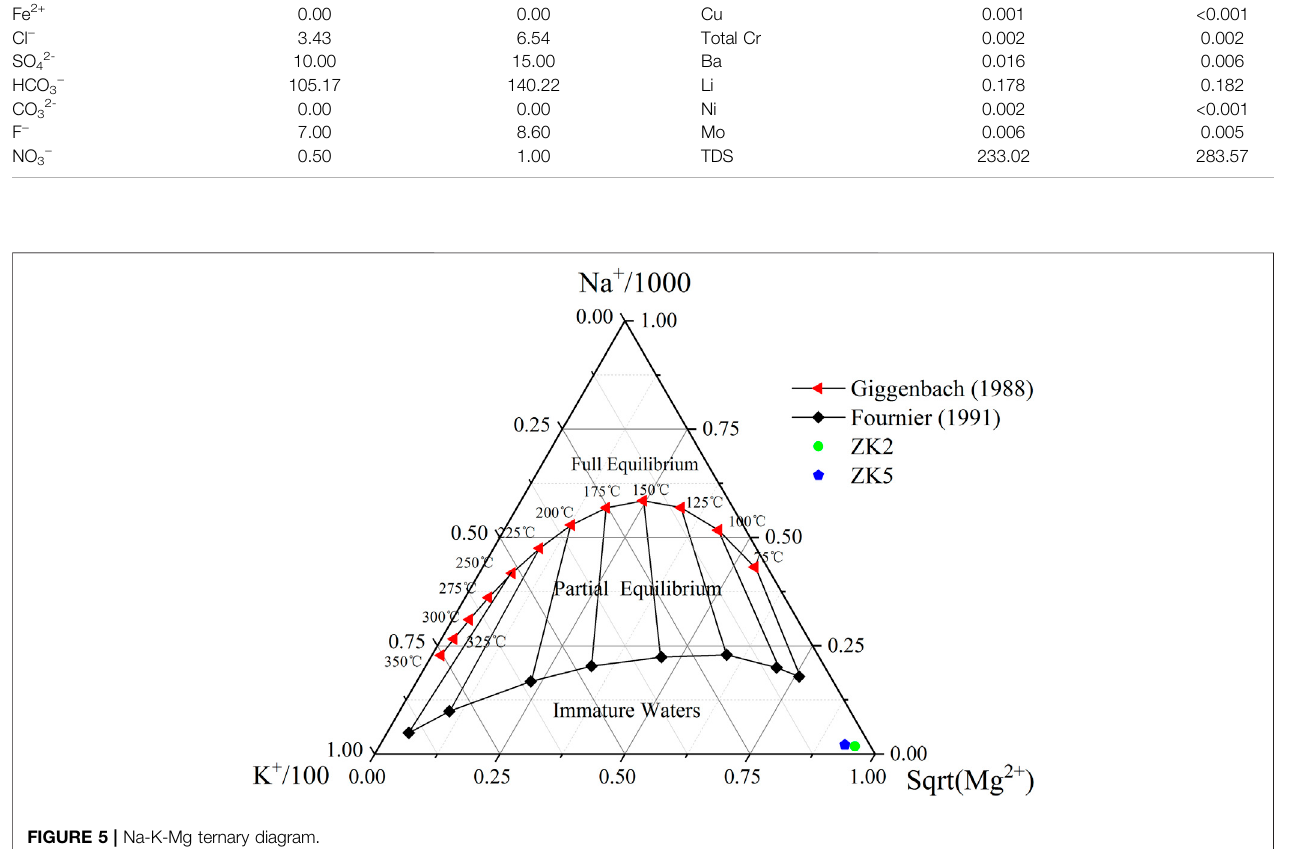
FIGURE 5 | Na-K-Mg ternary diagram.